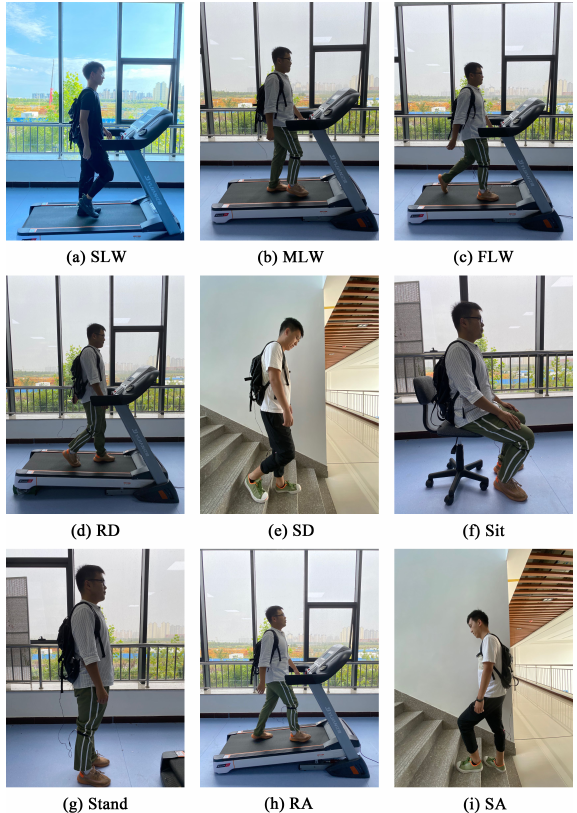
Figure 3. Data collection for locomotion